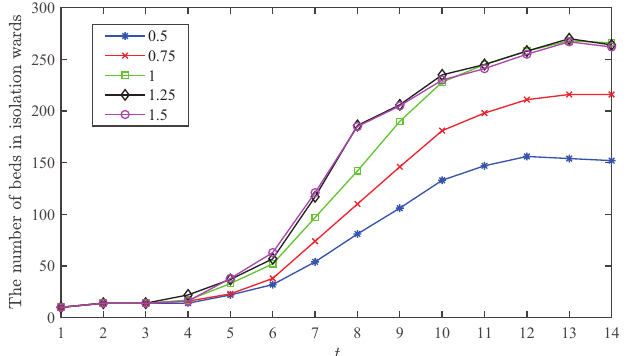
Figure 10. The number of beds in isolation wards in case 2.